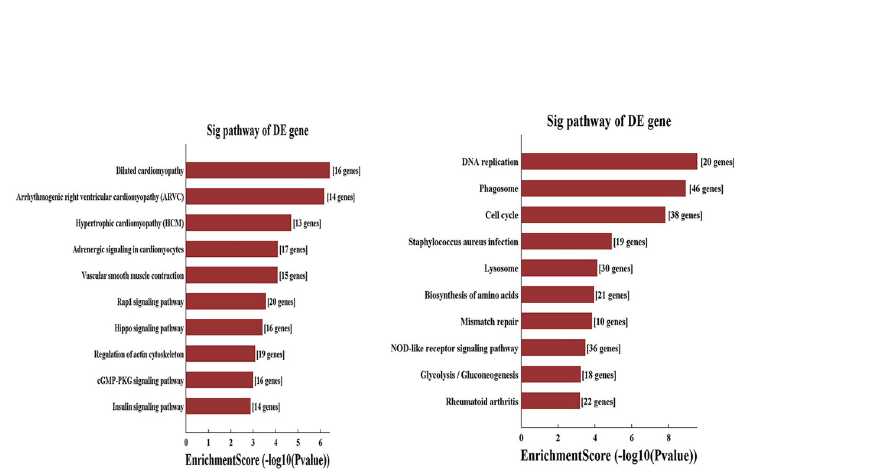
Fig 3. Kyoto Encyclopedia of Genes and Genomes enrichment analysis of the pathways. The gradient color represents the P-value; the size of the black spots represents the gene number.